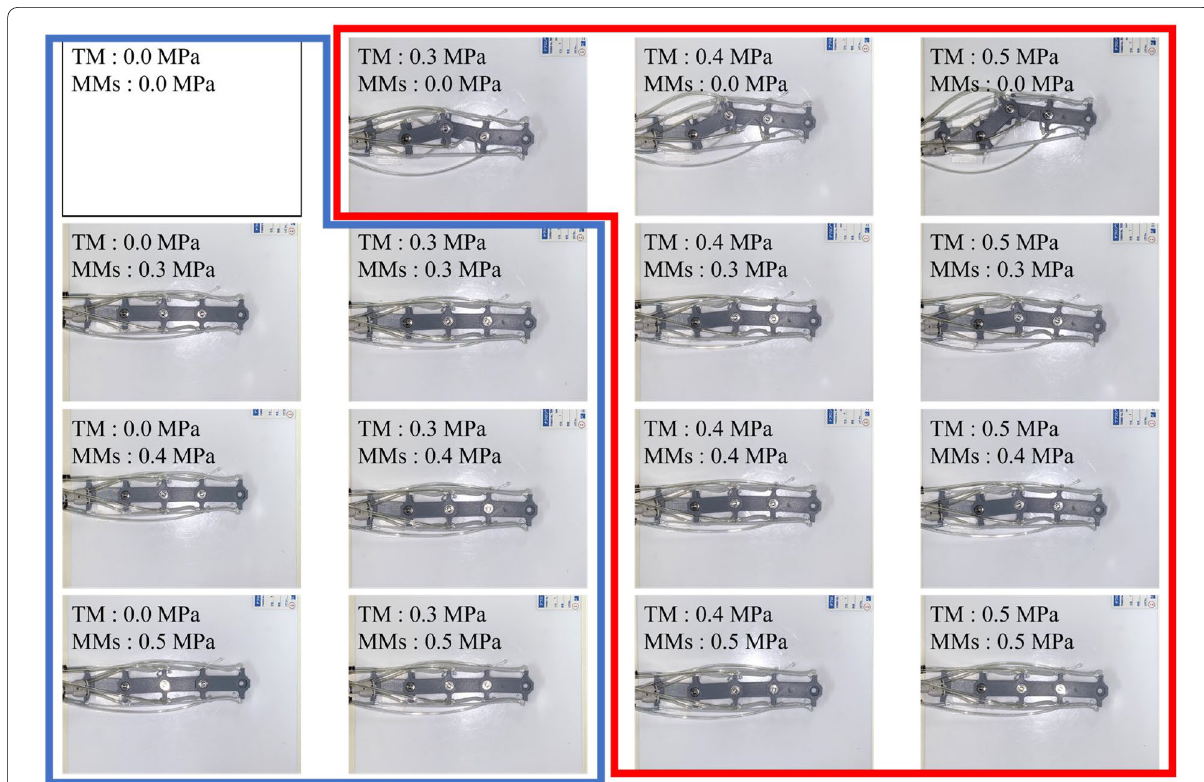
Fig. 7 Experimental results. MM and TM are actuated at air pressures of 0.0, 0.3, 0.4, and 0.5 MPa. Note that all the MMs are actuated by the same pressure at each